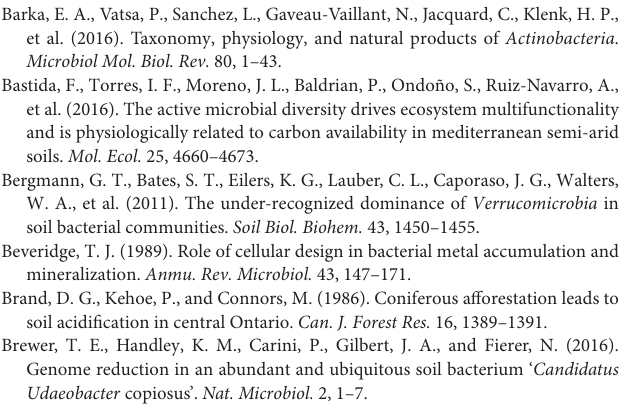
Supplementary Figure 1 | The two relations of ANOSIM analysis in five ecological types based on OTU abundance. Ordinate–the rank of the distance between samples; Abscissa–Between is the result between every two ecological types, and the other two are the results within their groups, respectively. Supplementary Figure 2 | Changes of Candidatus Udaeobacter , Chthoniobacterales, and Pedosphaeraceae with plant Gleason index. Supplementary Figure 3 | VPA shows the effects of plant richness and soil properties on soil bacterial community compositions (A) and alpha diversities (B) . Supplementary Table 1 | The bacterial taxonomy of the soil